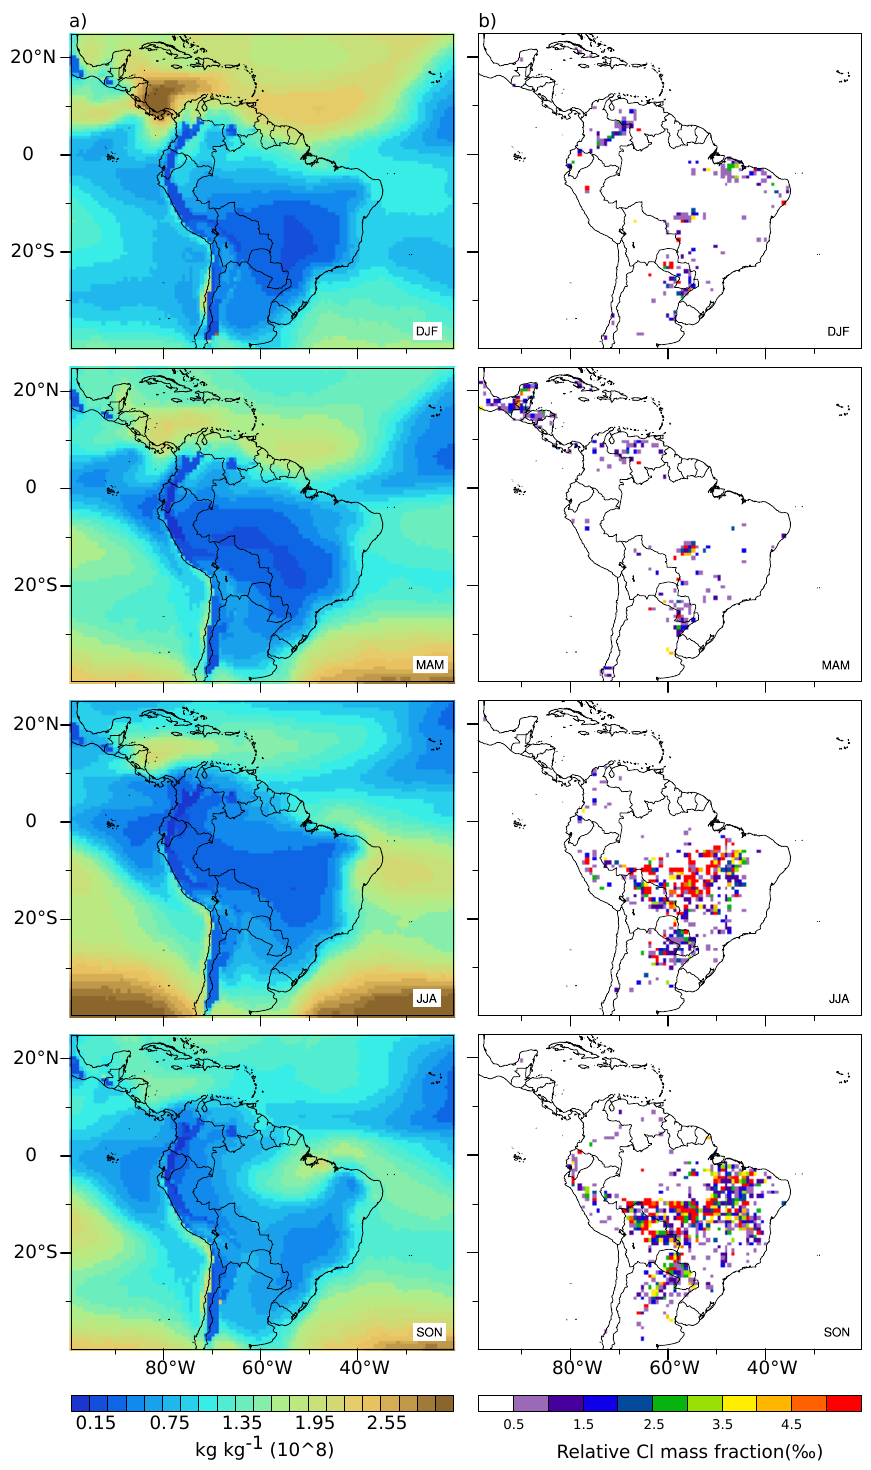
Figure 8. (a) Seasonal maps of sea salt concentration calculated from the MACC reanalysis model. (b) Seasonal maps of biomass-burning Cl mass fraction relative to sea salt. Cl mass ratio to NO x was estimated based on emission factors from Ferek et al.